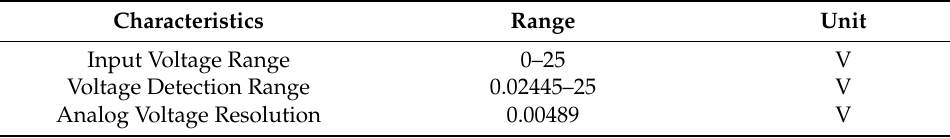
Figure 3. F031-06 voltage sensor module. Table 2. Technical characteristics of F